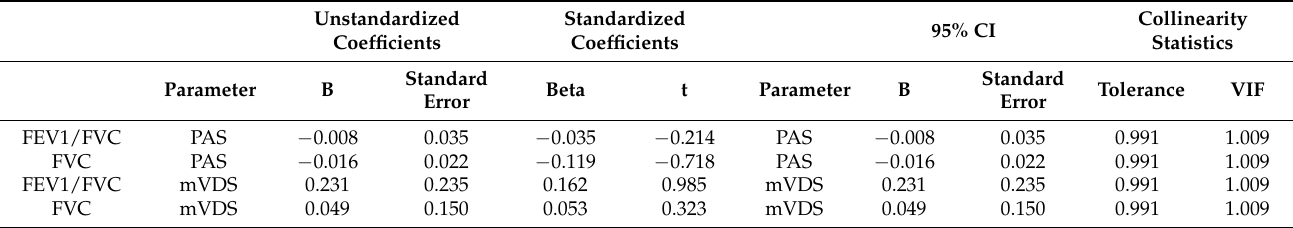
Table 4. Multivariate regression analysis (with the enter method) of the association between the penetration–aspiration scale (PAS) scores and PFT (FVC and FEV1/FVC), between the modified version of the videofluoroscopic dysphagia scale (mVDS) scores and PFT (FVC and FEV1/FVC) in the patients with brain-lesion-induced dysphagia.